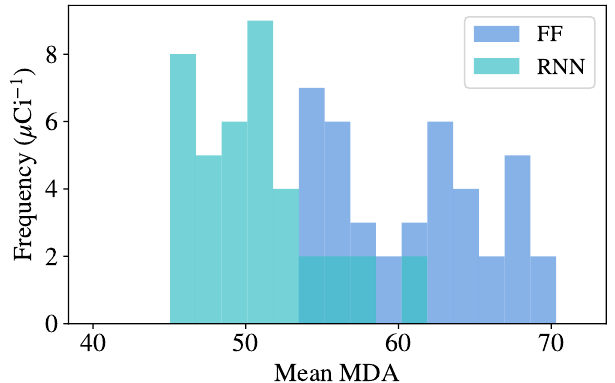
Figure 7. Histogram of mean MDA for RNN and feedforward (FF) ID networks evaluated on the validation set. Each model, 40 in total, is trained using a random value of the L2 regularization coefficient λ , number of kernels in the convolutional layer, and number of neurons in the first dense layer. This distribution shows a general trend of improvement when using recurrent layers. The models corresponding to the lowest mean MDA for both feedforward and recurrent networks are examined further on the test set.